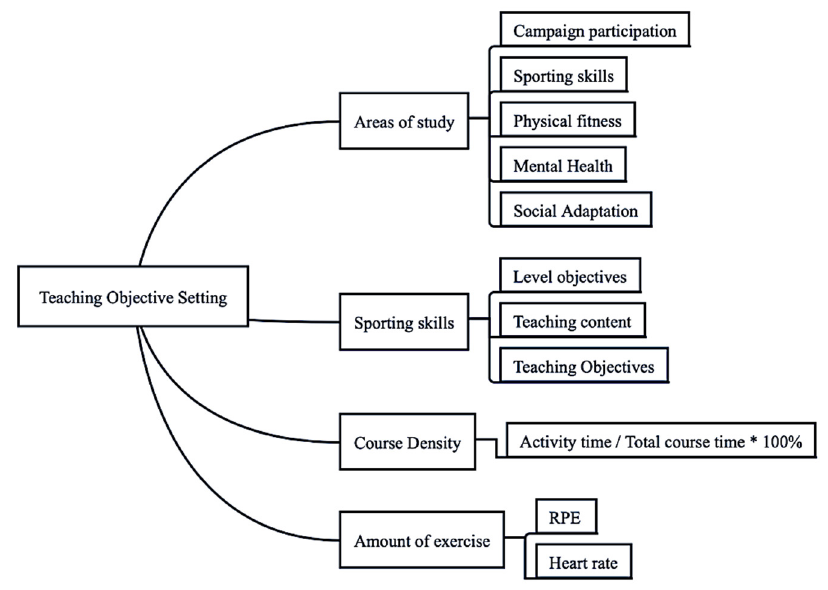
Figure 4. Figure of elements for setting teaching objectives.